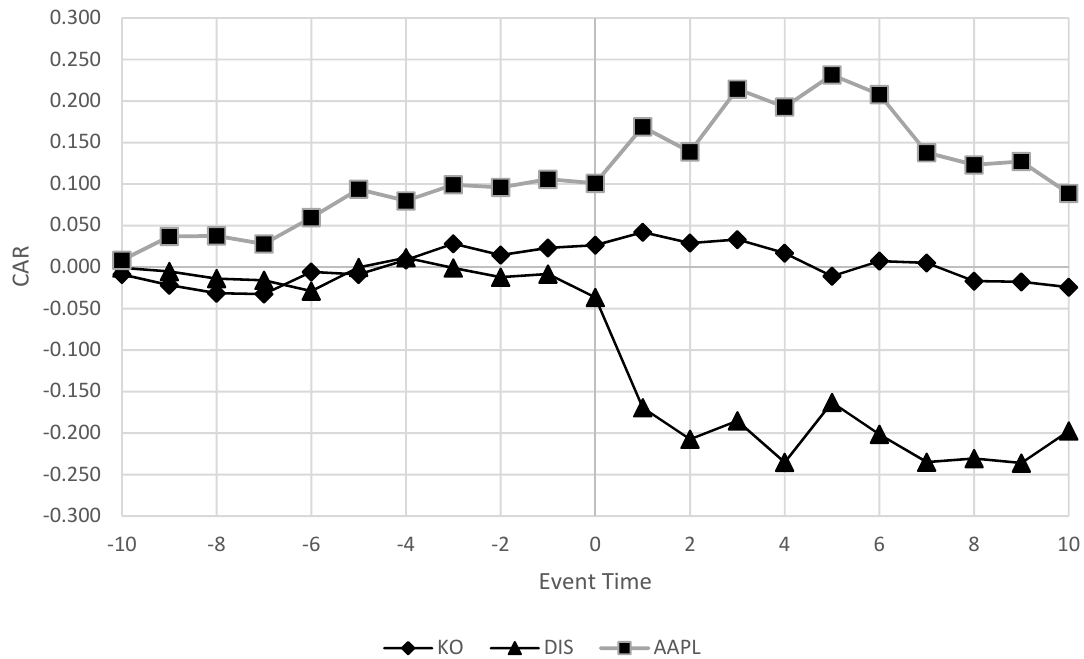
Figure A1. Plot of abnormal returns for the “9/11” Geopolitical event and event window ( − 10,10).